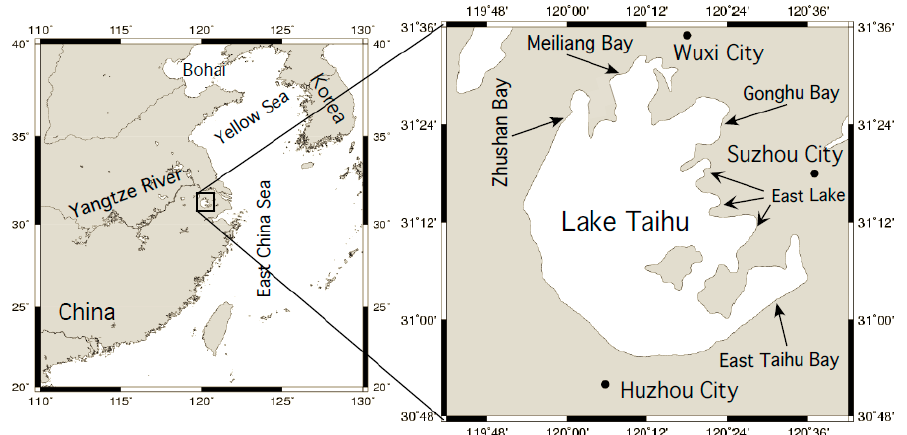
Figure 1. Maps of China’s inland Lake Taihu. The major regions in Lake Taihu are also marked.